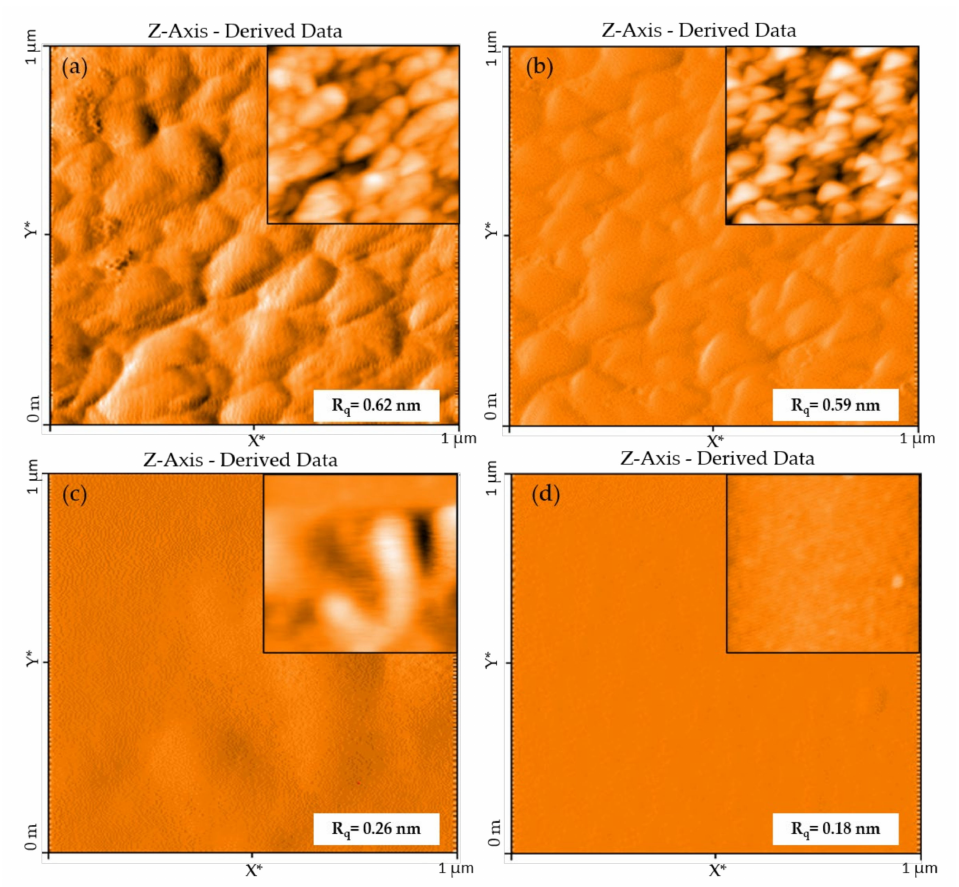
Figure 5. Atomic force microscopy (AFM) of GaN / Si(100) thin films grown at 800 ◦ C with ( a ) 60 nm GaN ( b ) 13 nm GaN ( c ) 13 nm GaN with AlN bu ff er and ( d ) 13 nm GaN with Al 2 O 3 / AlN bu ff er. Line fits are included in the upper right-hand corner of each